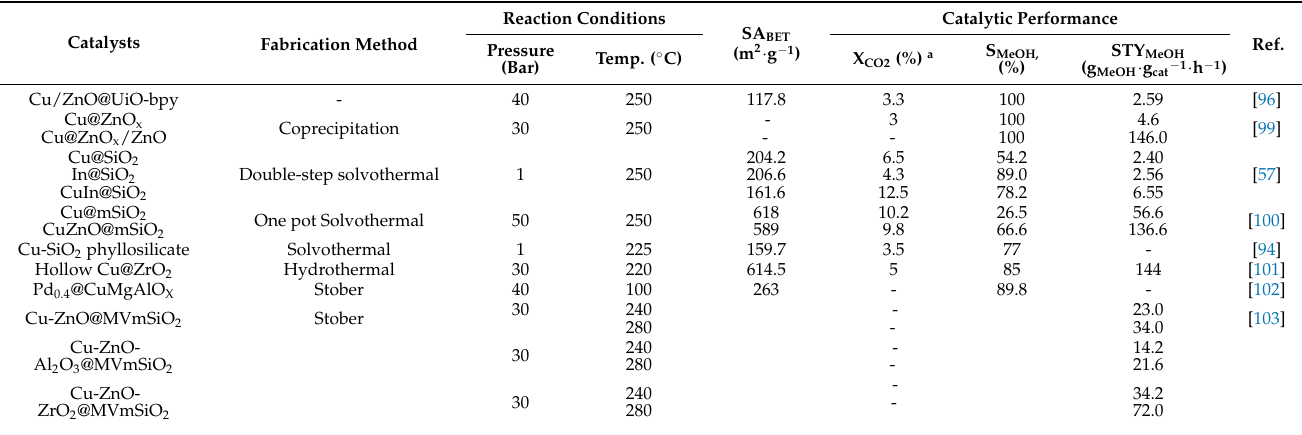
Table 2. Catalytic performance of core-shell catalysts in CO 2 hydrogenation to